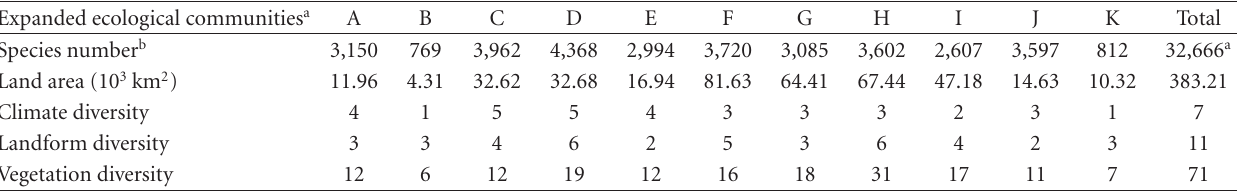
Table 2: Some characteristics of expanded ecological communities at the flora subregion scale. Expanded ecological communities a